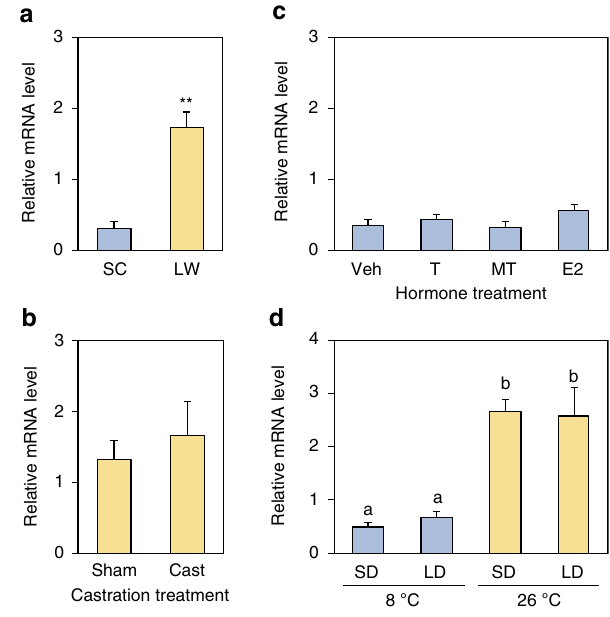
Fig. 4 Regulation of the LWS opsin gene by temperature. a LW (long day/ warm temperature)-induction of LWS expression in males (** P < 0.01, t - test; mean + SEM, n = 5). b Effects of castration (Cast) on LWS expression under LW conditions. ( P > 0.05, t -test; mean + SEM, n = 4 – 5). c Effect of testosterone (T), methyltestosterone (MT) and estradiol (E2) on LWS expression under SC conditions ( F 3,16 = 1.53, P > 0.05, ANOVA; mean + SEM, n = 5). Veh: vehicle. d Effect of temperature in combination with short-day (SD) and long-day (LD) conditions on LWS expression. Different